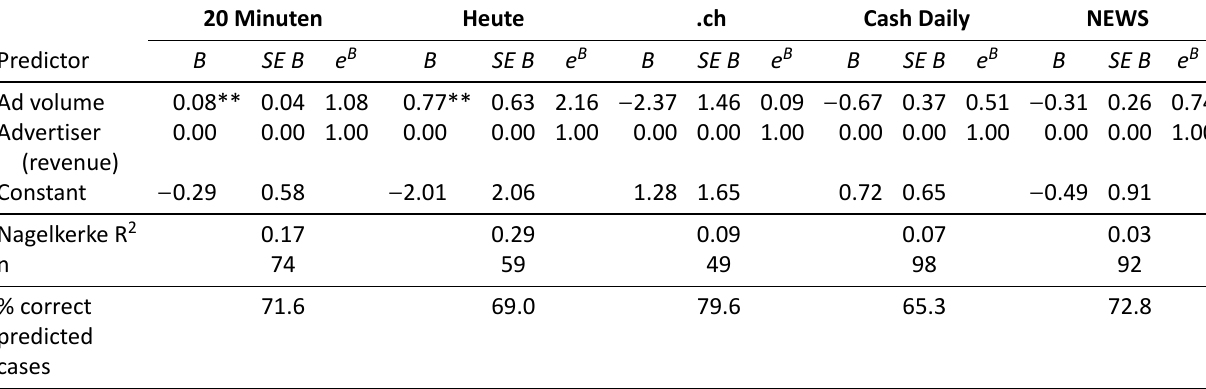
Table 4. Individual model with regard to the presented facts. 20 Minuten Heute .ch Cash Daily NEWS